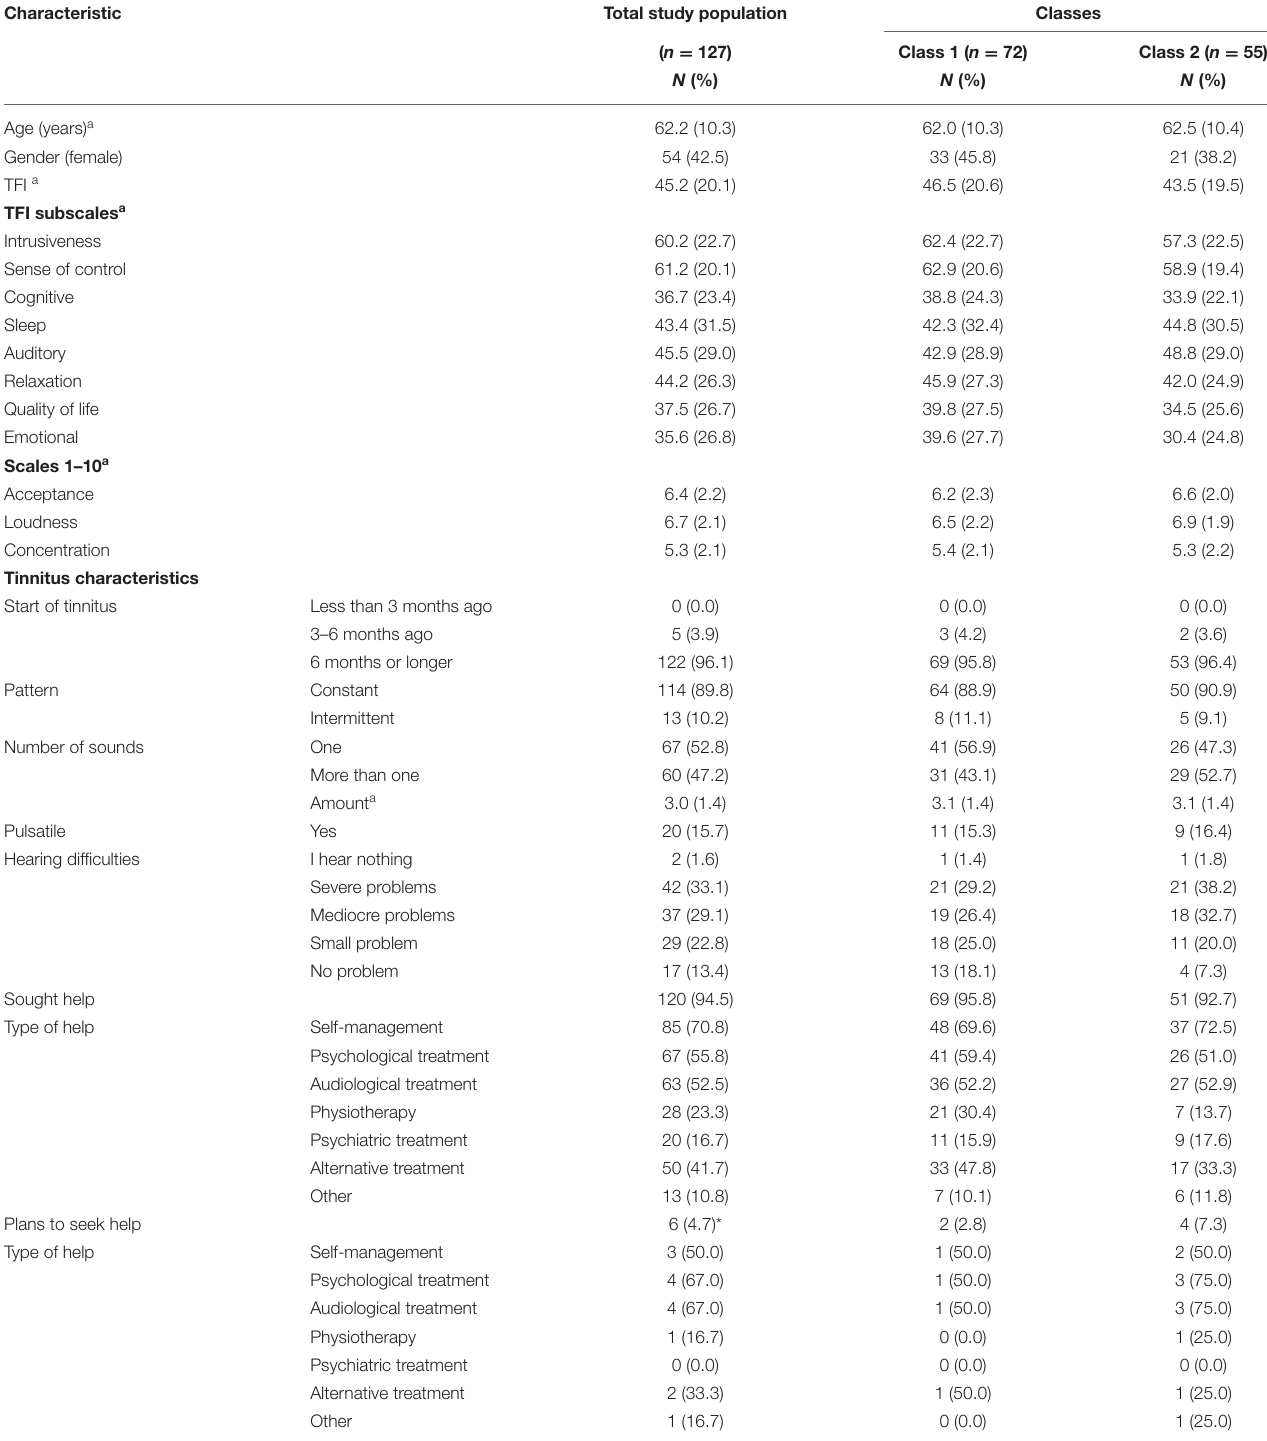
TABLE 2 | Baseline characteristics of study participants for total study group and split per different classes (based on Table 5 ).